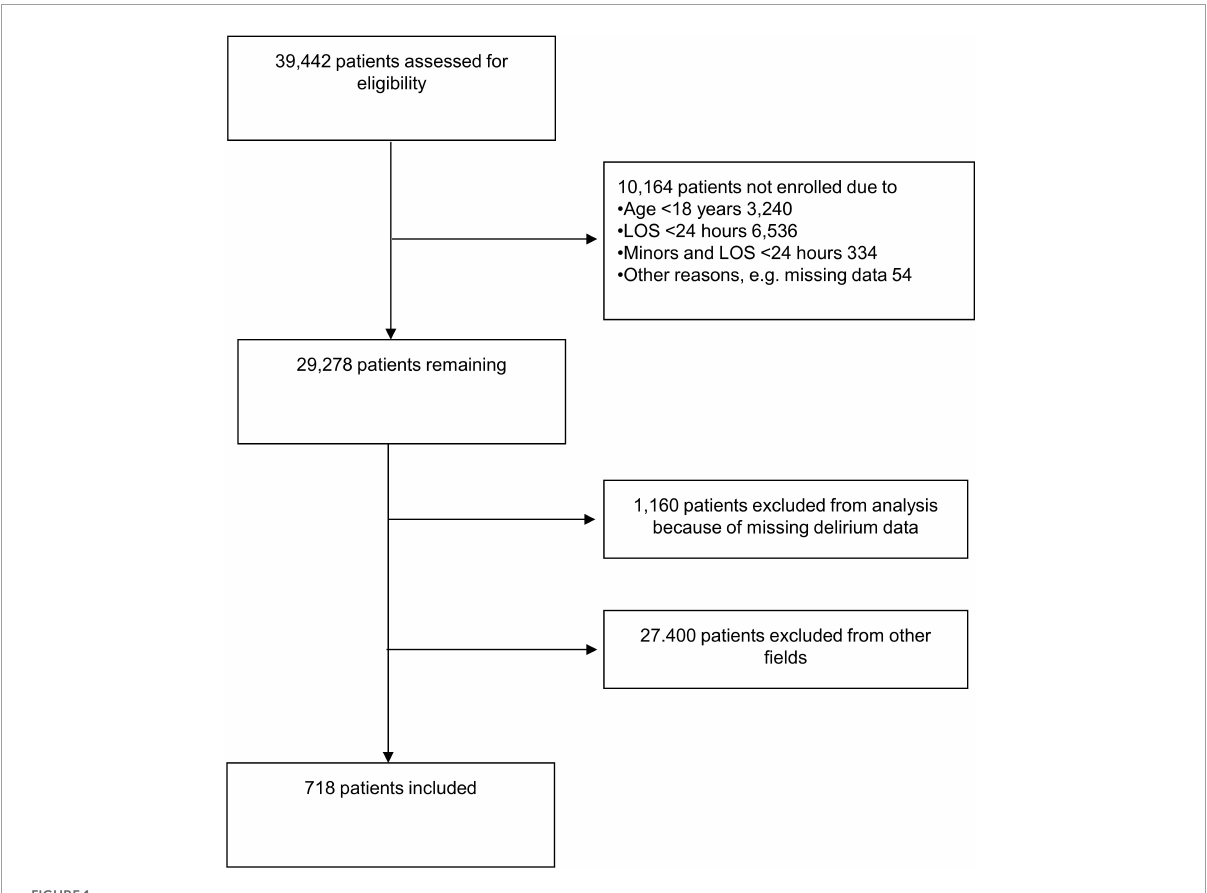
FIGURE1 Flow diagram of patient selection. LOS, length of